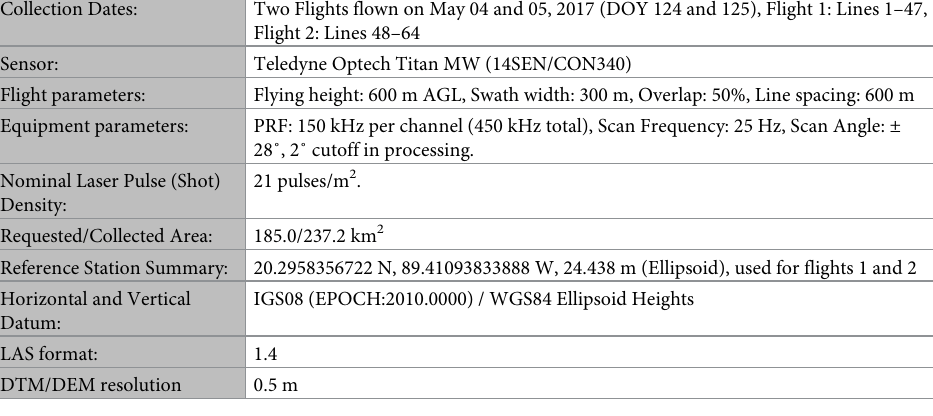
Table 1. Lidar data collection parameters �